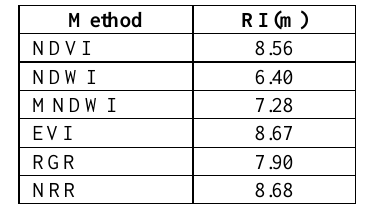
Table 2. RI values for the extracted coastlines using coastline extracted from Lg-DEM as reference.